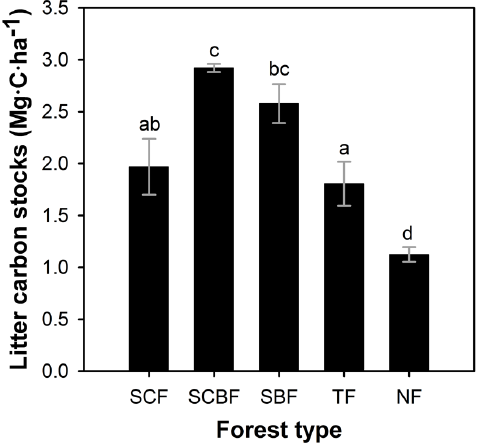
Figure 3. Litter carbon stocks in different forests. Different letters indicate significant differences across forest types (S ‐ N ‐ K test, p < 0.05). Error bars denote standard errors.